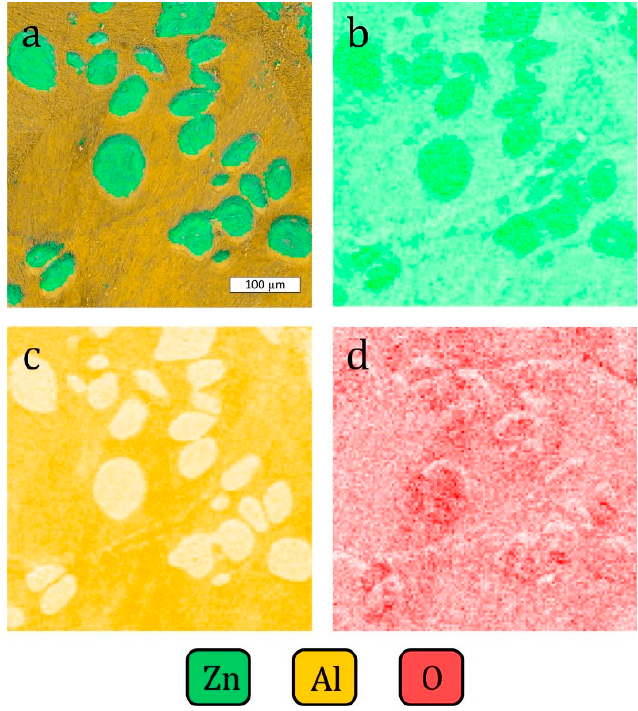
Figure 12. SEM and EDX images showing the distribution of elements on the sample surface after polarization up to the potential +300 mV vs. E corr : ( a ) SEM image merged with zinc and aluminum, ( b ) zinc, ( c ) aluminum, ( d ) oxygen. Element-rich areas are darker in the image. After reaching a potential of − 675 mV vs. Ag/AgCl (+450 mV vs. E corr ) the current density